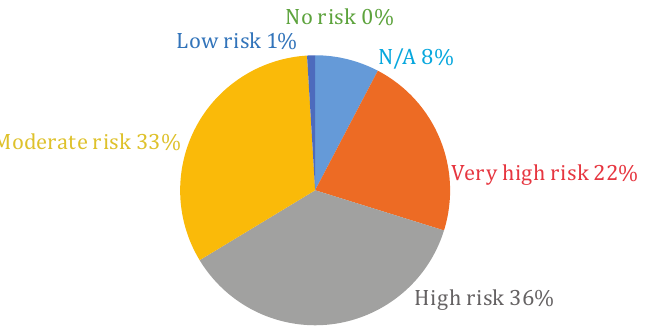
Figure 8. Rating of bridge distress (Water leakage)